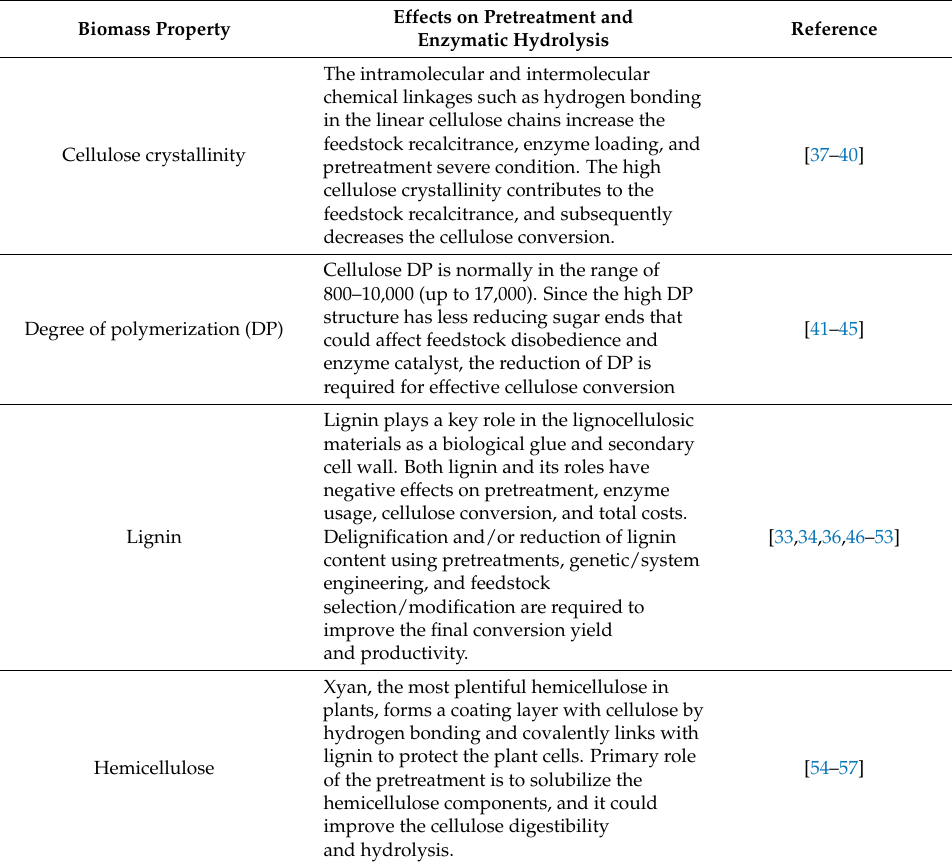
Table 2. Lignocellulosic biomass structural/chemical properties and their recalcitrant effects on pretreatment and enzymatic